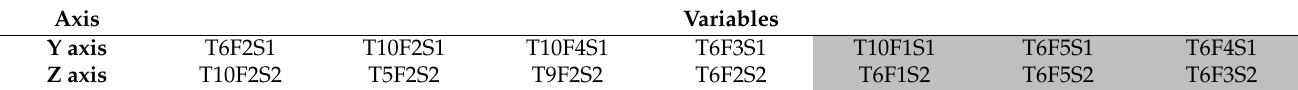
Figure 10. The top seven and three variables that contribute to data variability. ( A ) The top seven contributing variables to the radial-ulnar axis; ( B ) The top seven contributing variables to the proximal-distal axis; ( C ) The top three contributing variables to the radial-ulnar axis; and ( D ) The top three contributing variables to the proximal-distal axis. Table 3. Seven and three variables (in gray) that contribute the most to data variability. Axis Variables Y